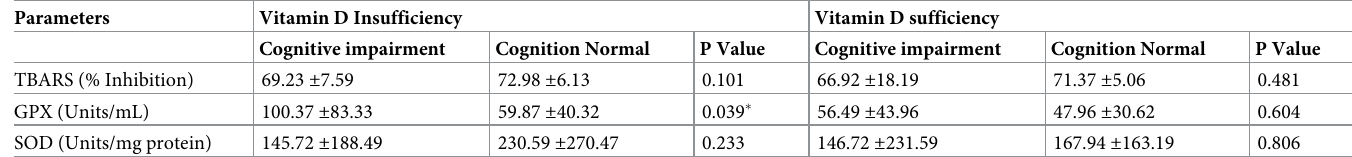
Table 5. Comparison of oxidative stress markers among non-diabetic subjects with vitamin D insufficiency and cognitive